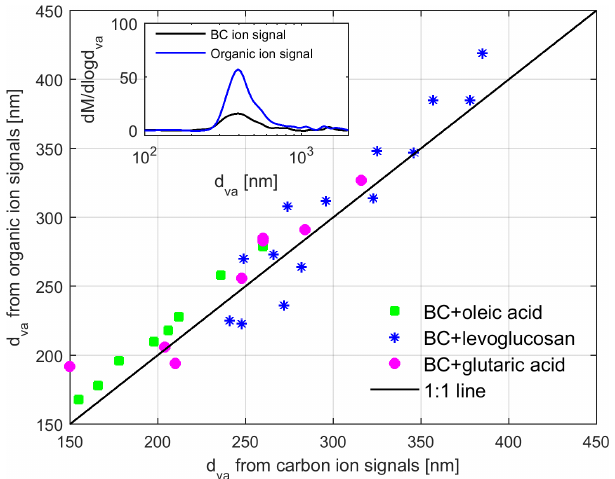
Figure 4. Experimental and theoretical critical supersaturations for pure BC particles for different particle mobility diameters. The the- oretical curve were calculated with Eq. (10) with A and B as fitting parameters. The experimental data were the average of two sets of experiments. Error bars represent the minimum vs. maximum val- ues of supersaturations from the two data